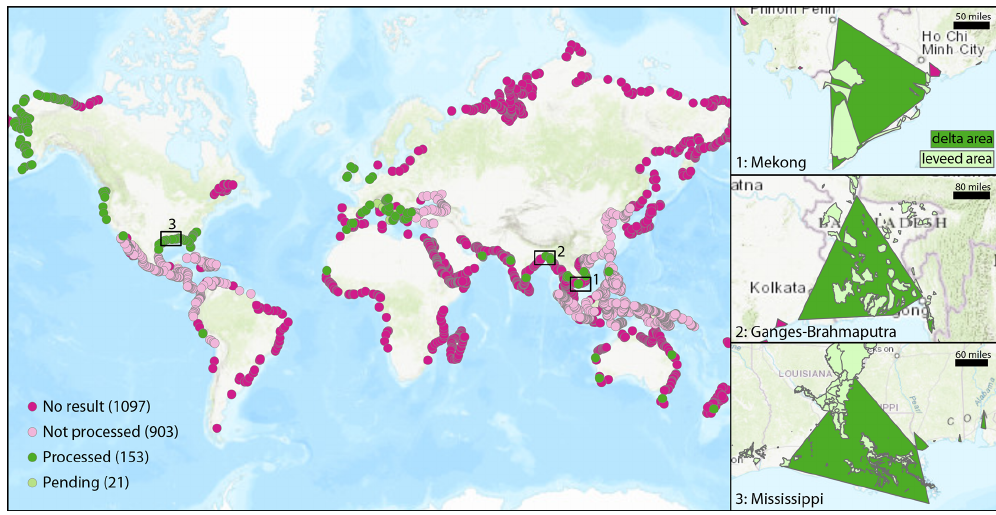
Figure 2. Distribution of delta levee dataset completeness and data availability in release of openDELvE (v1.0). Polygons encompass the four-point deltaic extent as defined by Edmonds et al.